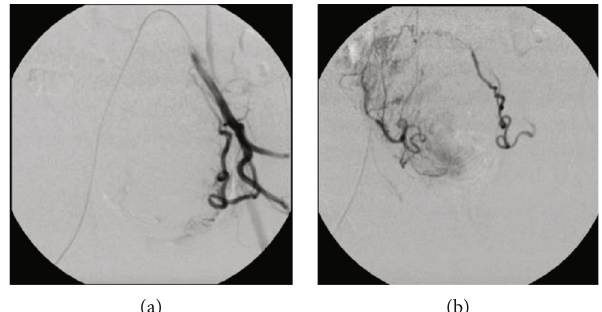
Figure 2: Digital subtraction angiography postembolization demonstrating e ff ective embolization of the left (a) and right (b) uterine arteries.